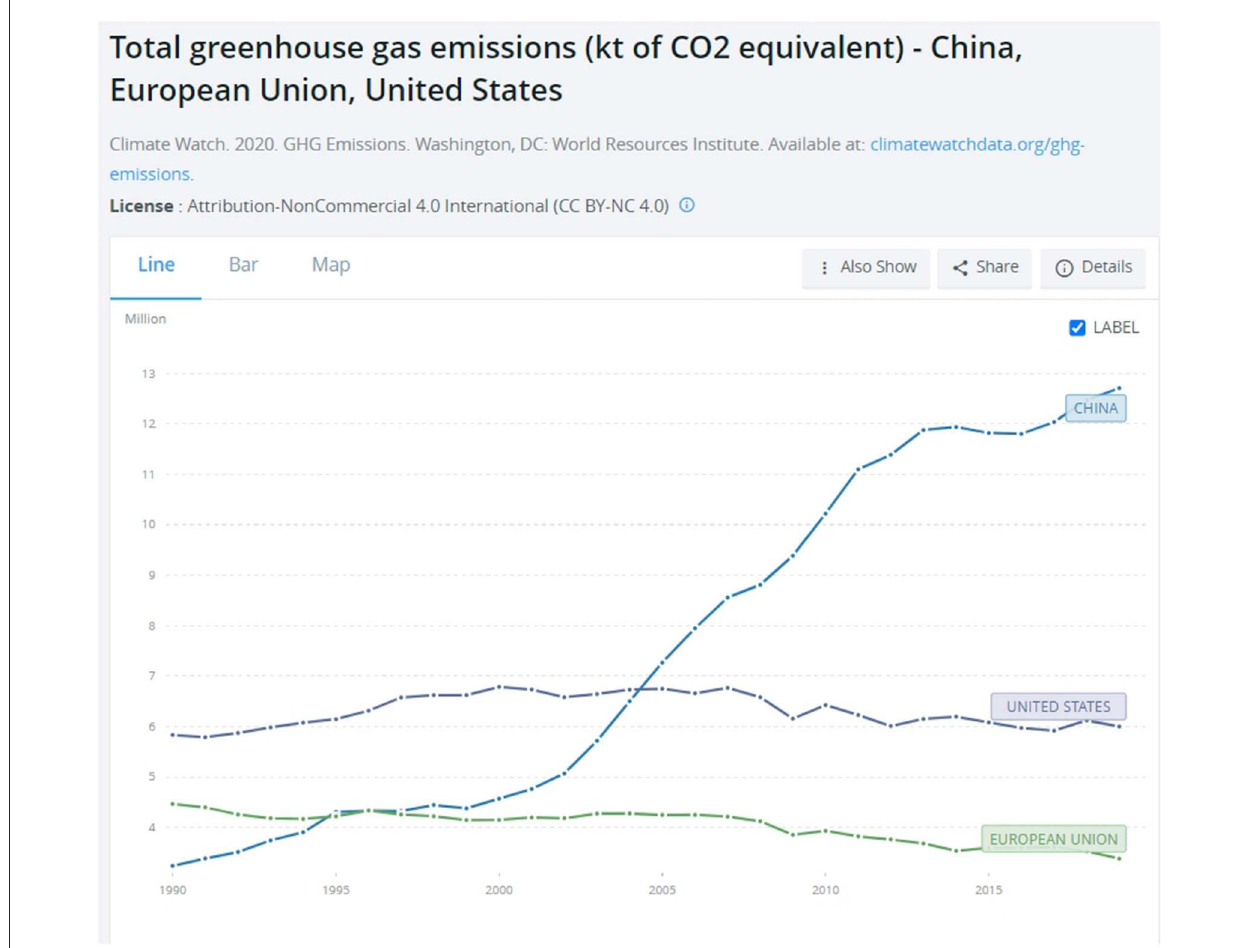
FIGURE9 CO 2 emissions of China, the US and EU. Evidence from the World Bank, available online at: https://data.worldbank.org/indicator/EN.ATM.GHGT.KT. CE?locations=CN-EU-US (accessed February 06, 2023).